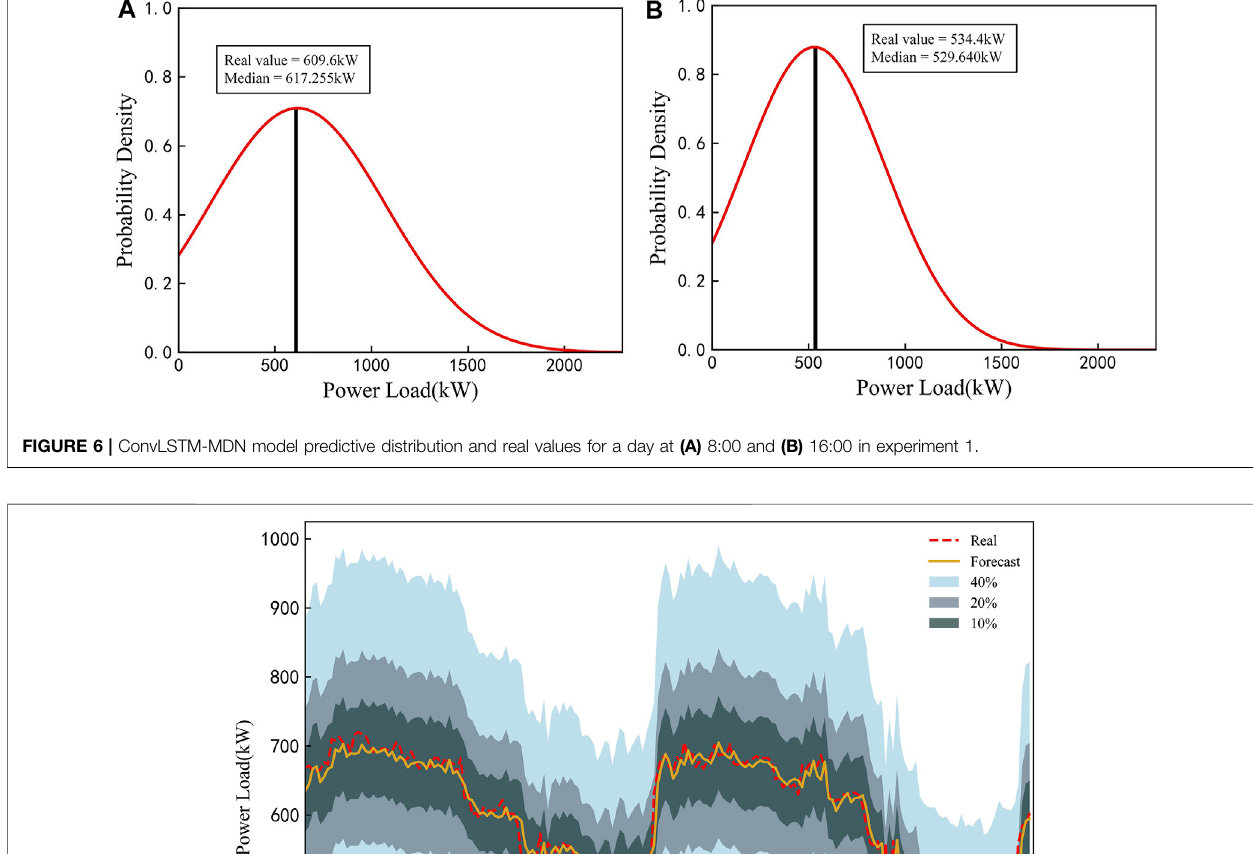
Frontiers in Energy Research |